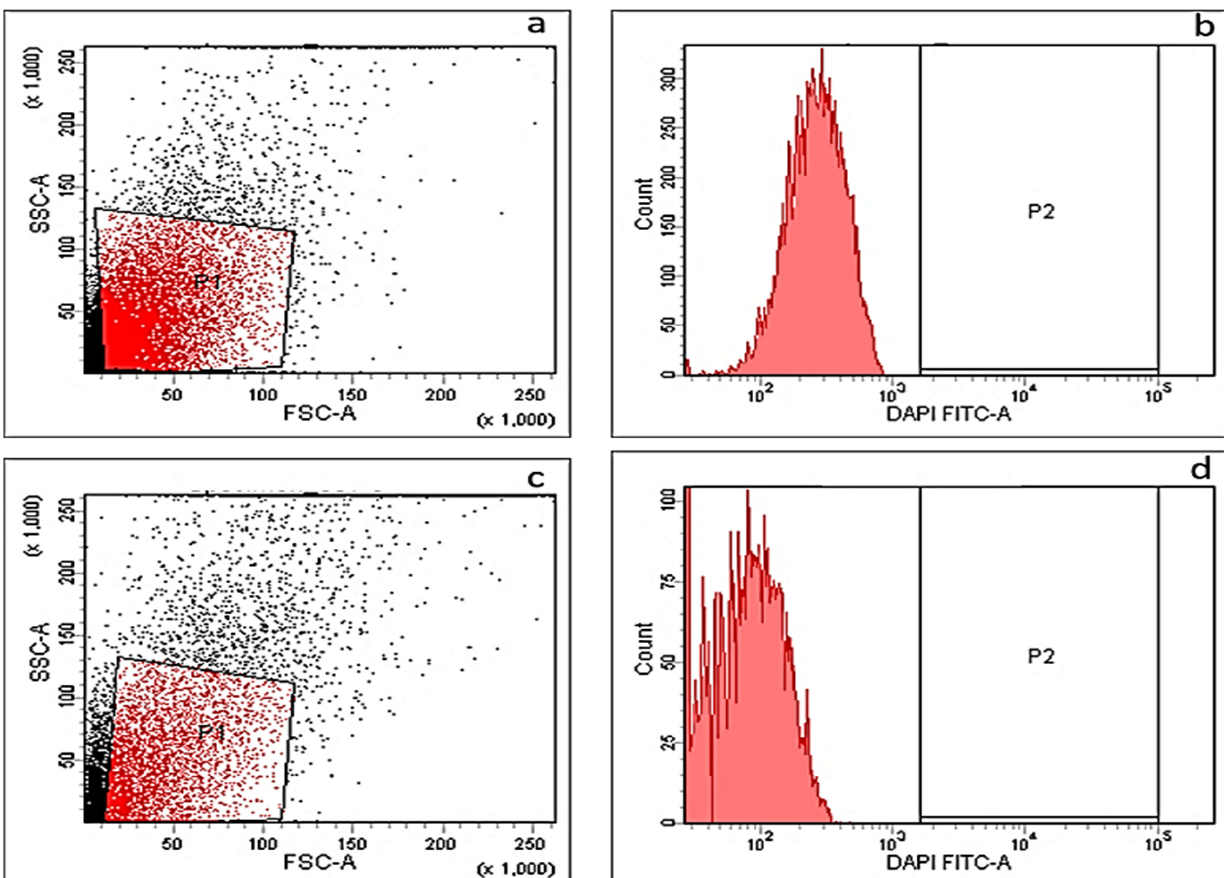
Figure 4. A representative example for MRSA isolates showing nonsignificant change in membrane depolarization detected by flow cytometer. Dot plot ( a ) and histogram ( b ) before treatment (showing a fluorescent gap of 52.6%), dot plot ( c ) and histogram ( d ) after treatment (showing a fluorescent gap of 51.3%).